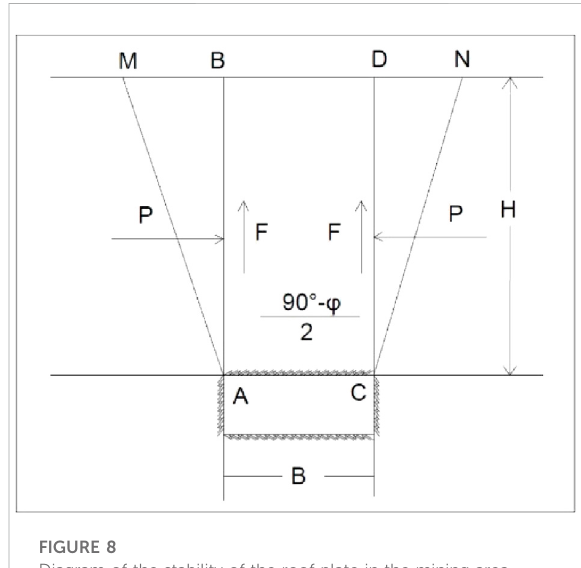
FIGURE 8 Diagram of the stability of the roof plate in the mining